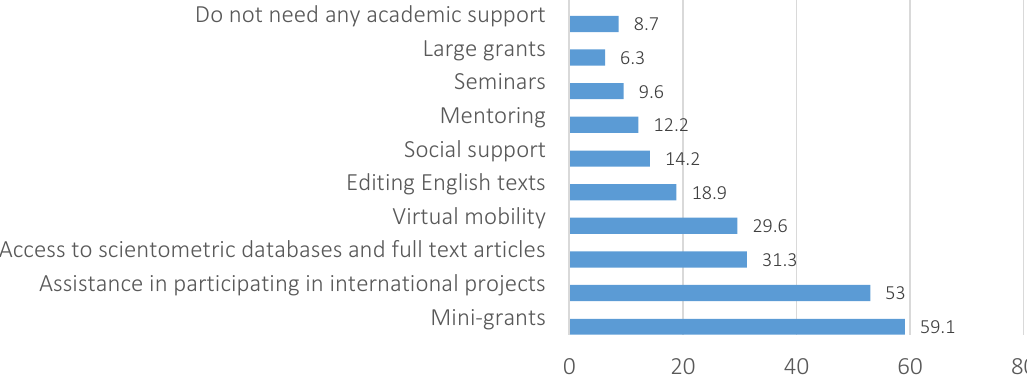
Figure 3. Answers to the question “What forms of academic and social support do you